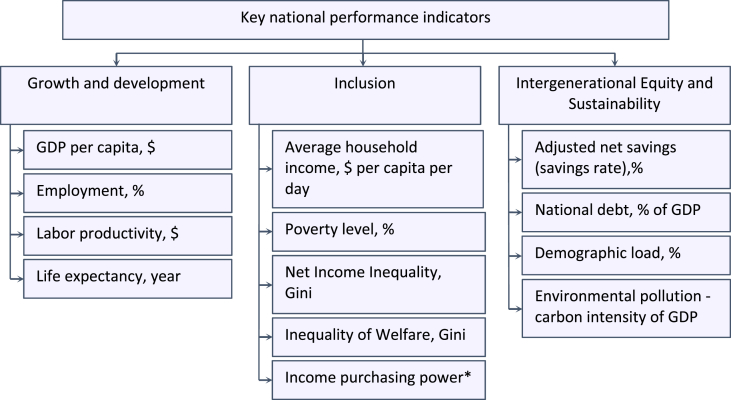
Key indicators of the performance of inclusive development [4].